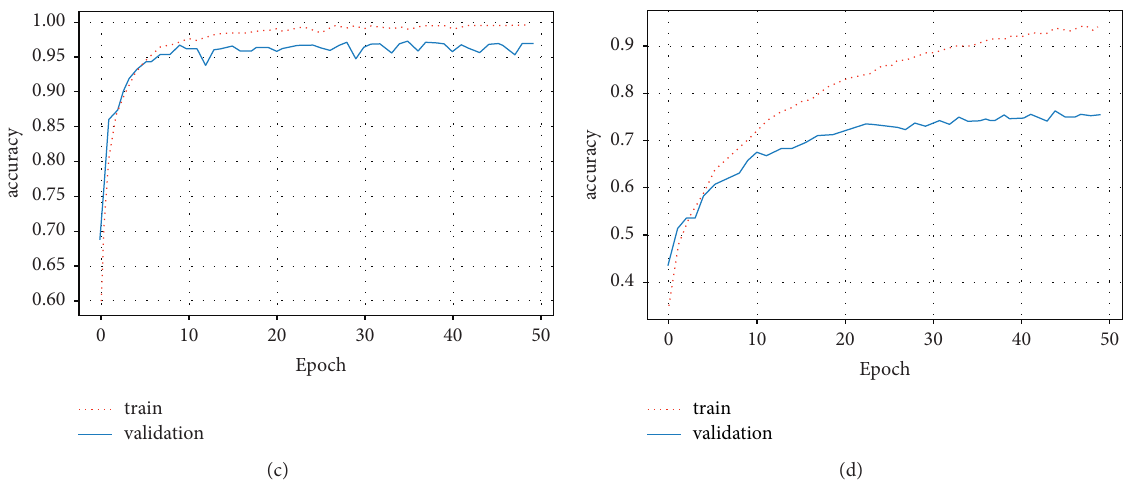
Figure 10: Model training iterative process. (a) CNN-BLSTM highest accuracy � 99.55%. (b) CNN-LSTM highest accuracy � 99.45%. (c) CNN highest accuracy � 97.9%. (d) DNN minimum accuracy �